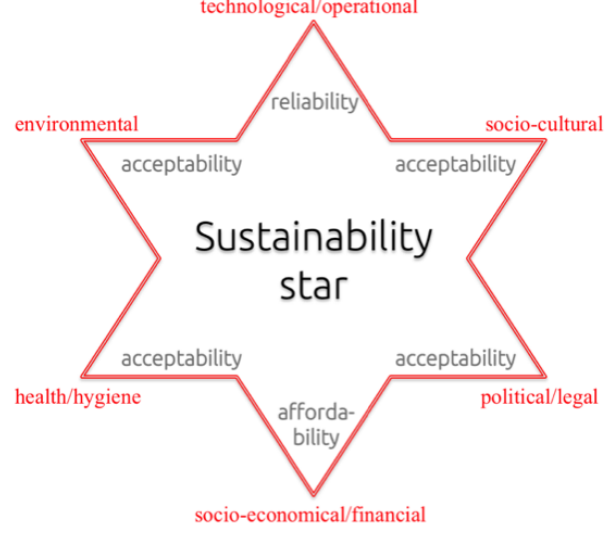
Figure 2. The sustainability star that was used to visualize and summarize the six main-criteria considered in the MCTA. The final selection of sub-criteria (Table A.8) constitutes a synthesis of criteria from [23,36,37,50] (cf. Table A.6). From a total of 84 sub-criteria considered in the MCTA, 80 and 75 are applied for assessing cooking and sanitation technologies, respectively (Table